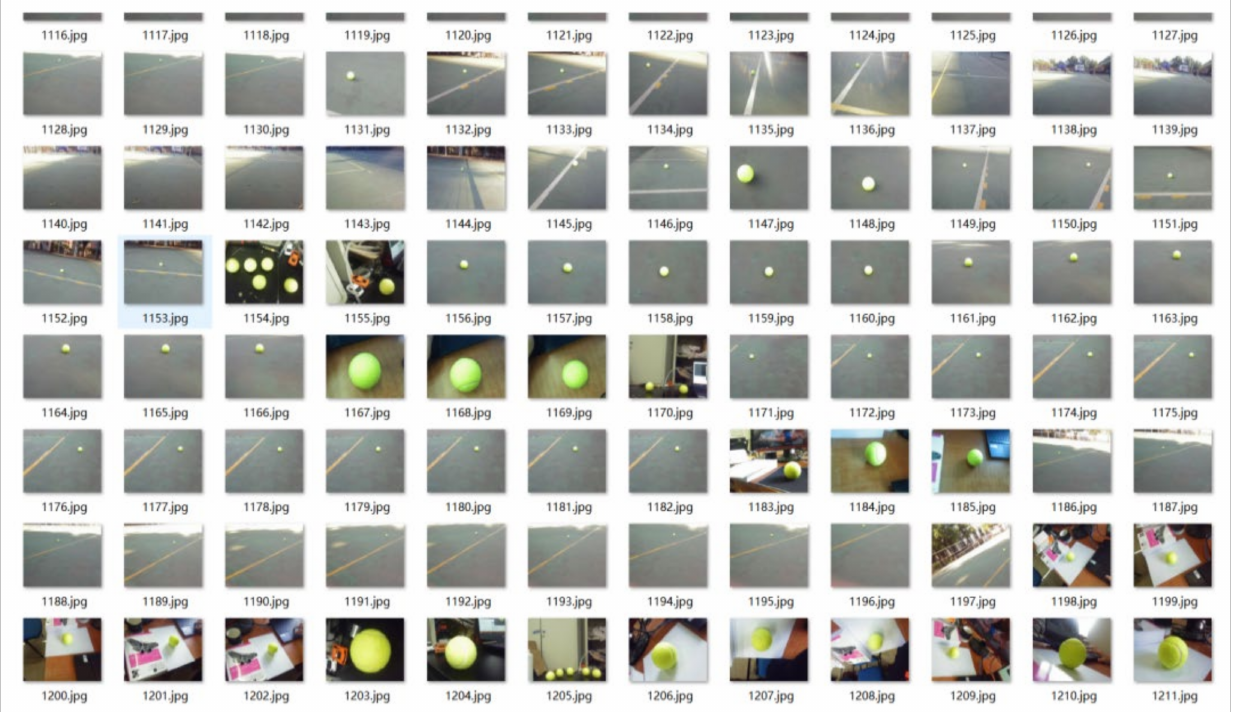
Figure 9. Sample tennis ball images.